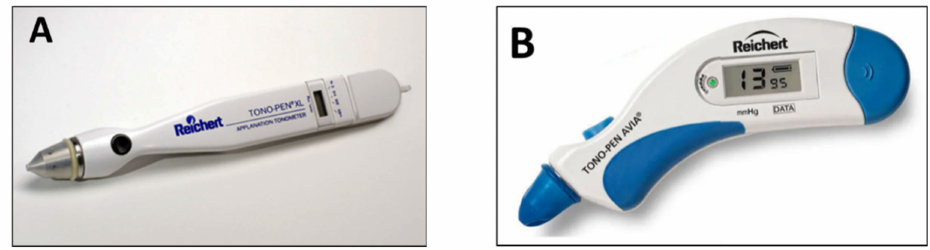
Figure 5. ( A ) Tono-Pen; ( B ) Tono-Pen